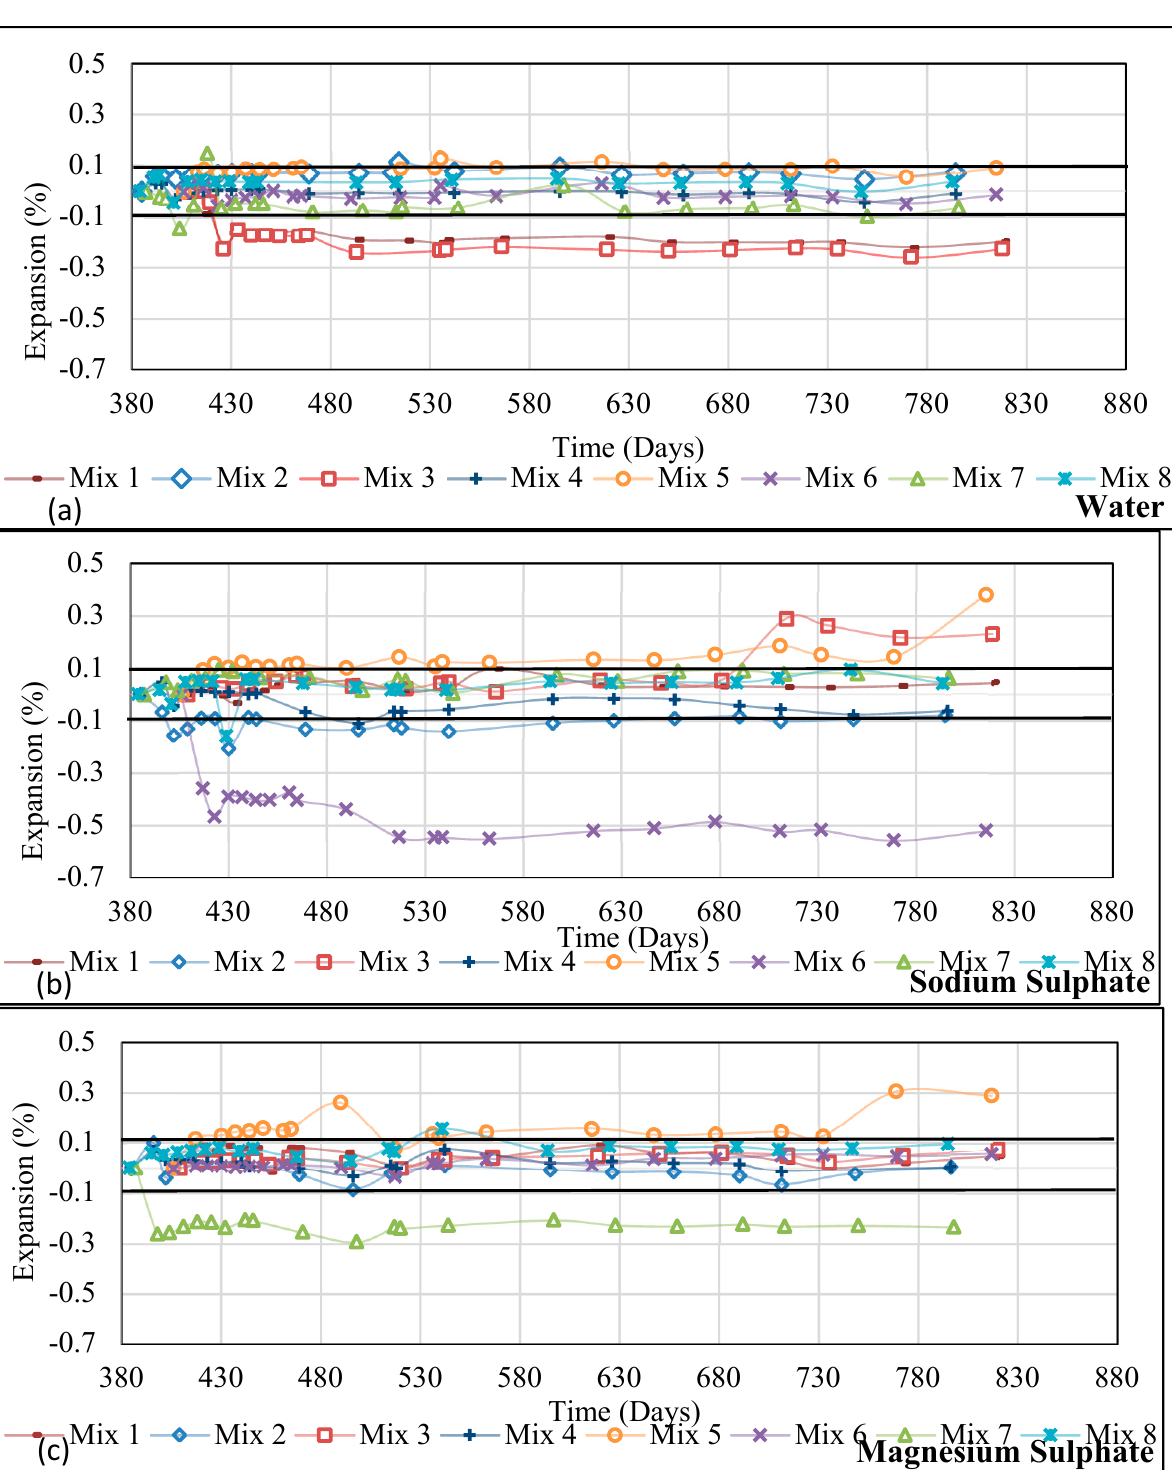
Figure 6. Expansion/shrinkage of Group 2 AASC mixes (cured for a year before exposure) during immersion in different solutions [( a ) Water, ( b ) Na 2 SO 4 , ( c ) MgSO 4 ]; ±0.1% tolerance accepted by ASTM C1012 is shown on the figures as full horizontal black lines. The maximum shrinkage occurring in the three mixes (except for Blend 1) was 0.1% and this was within the acceptable level for structural elements as per ASTM C1012/C1012M- 18a standard